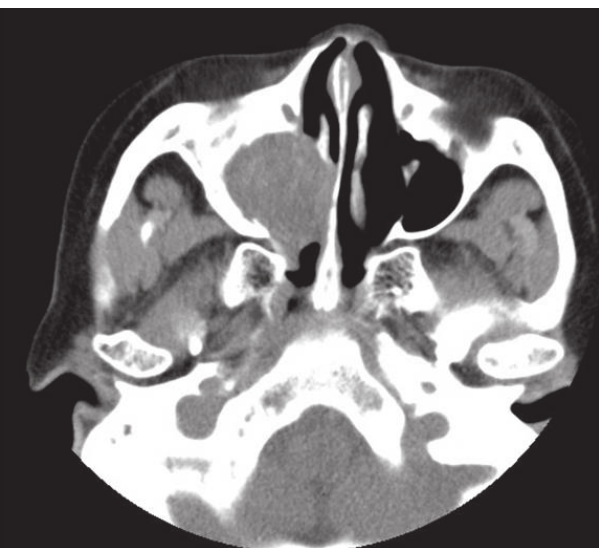
Figure 2. Axial view of computed tomography (case 2) showing bone erosion of the posterolateral and medial wall of right maxillary sinus.